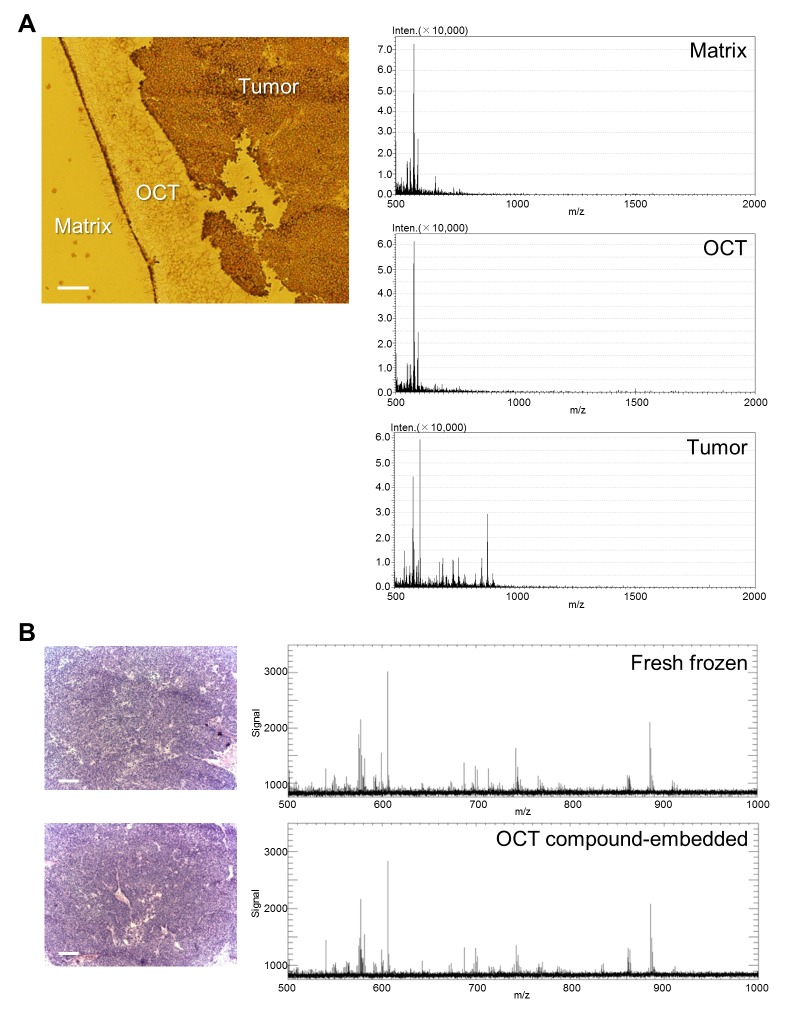
Direct tissue mass spectrometric analysis of prostate cancer xenograft tissues.Matrix coated tissue was subjected to negative ion mode HR-MALDI-IMS. A, Resulting averaged mass spectra of each region (upper panel, matrix; middle panel, OCT+matrix; lower panel, tumor + matrix) in the mass range of m/z 500–2000. The x axes show m/z, and the y axes show the signal intensity of mass spectra. The corresponding optical images are also shown. The scale bar represents 200 µm. B, H&E images of fresh frozen (upper panel) and OCT compound embedded (lower panel) xenograft tumor specimens. The scale bar represents 200 µm. Resulting averaged mass spectra of each xenograft tumor tissue (upper, fresh frozen; lower, OCT compound embedded) in the mass range of m/z 500–1000.